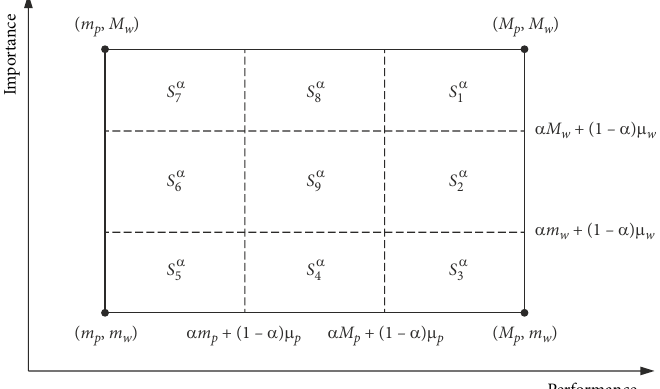
Figure 6. Corresponding areas to the categories of attributes in 9Qc-IPA method